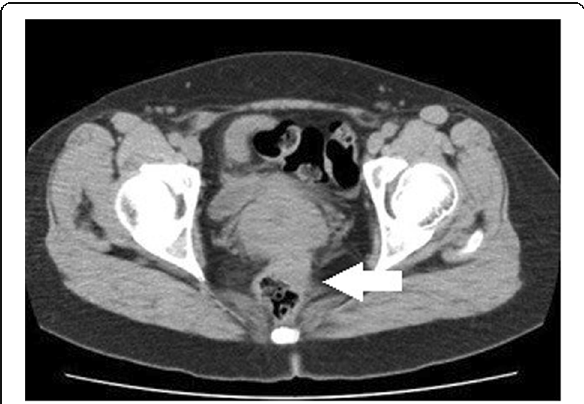
Fig. 4 Computed tomography shows the 40-mm mass on the anterior wall of the rectum